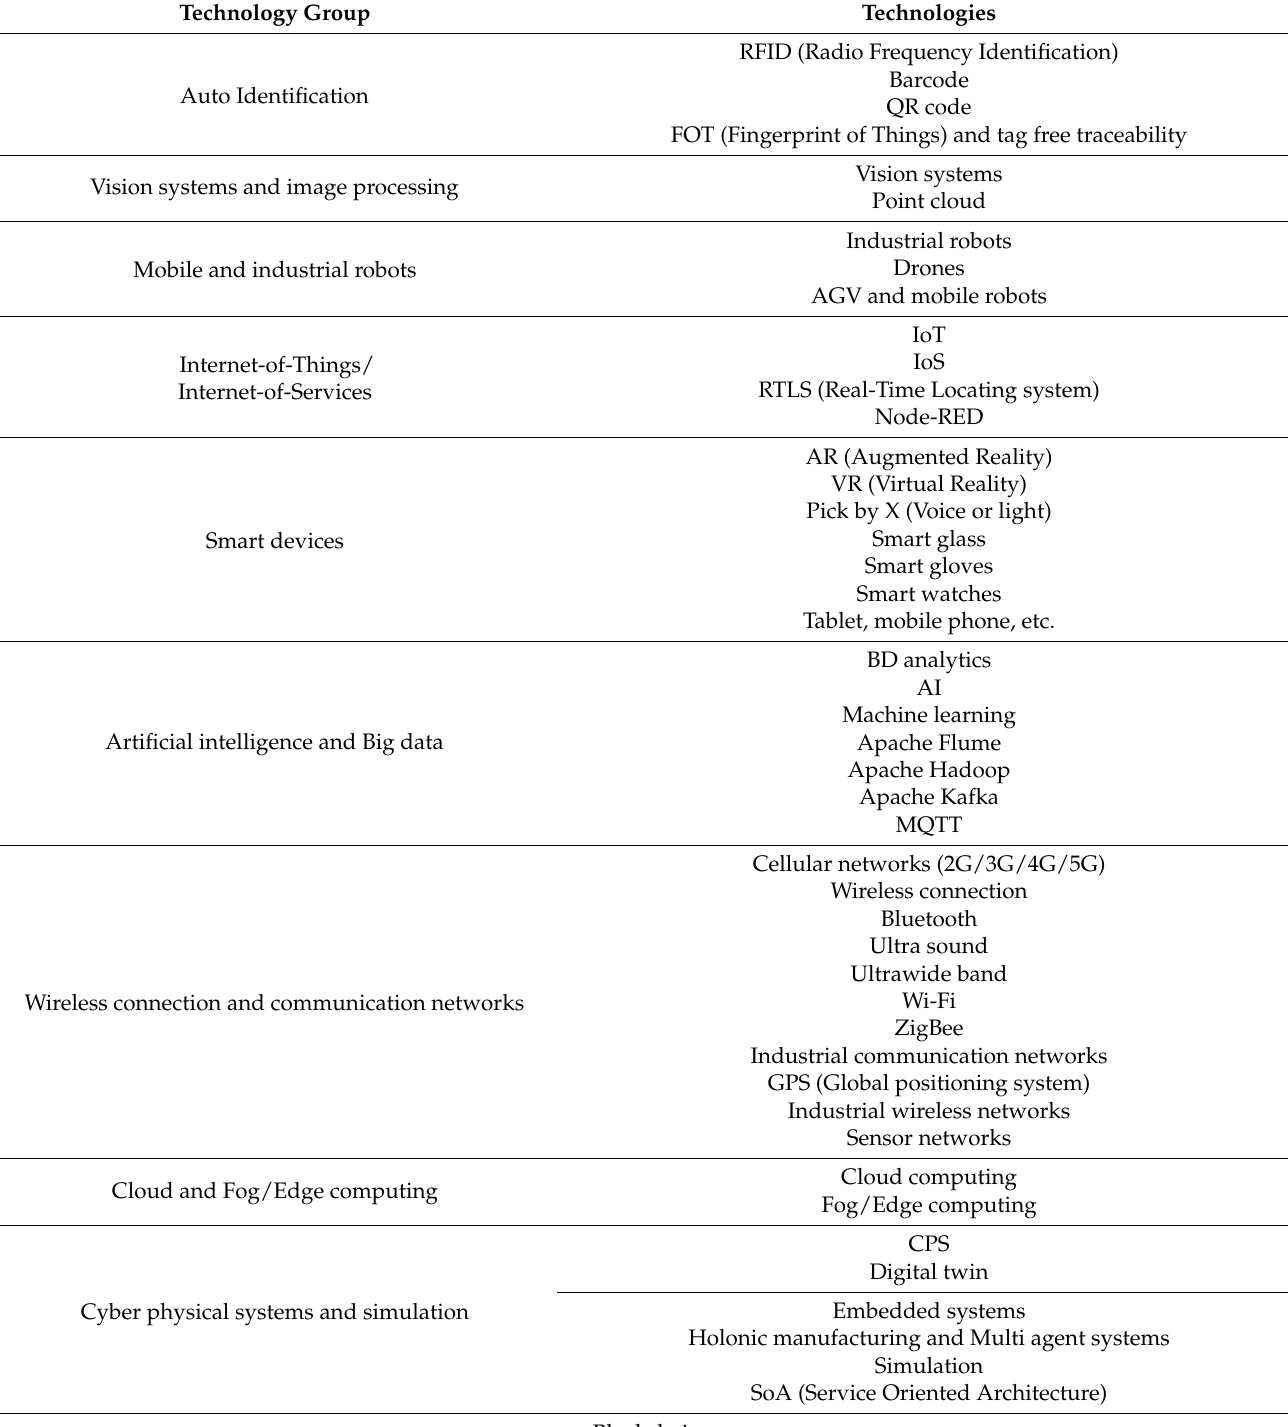
Table 2. Identified production logistics data-driven enabling